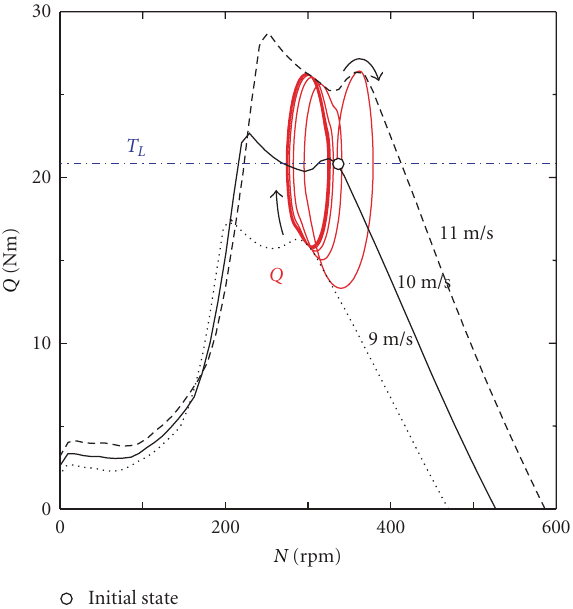
Figure 25: Locus of torque, Q , of pulsating wind in the case where V = 10 m/s, T = 32s, I = 5kgm 2 . Constant load torque is T L = 0 20.8 Nm. Final average rotational speed is N ave = 296 . 2